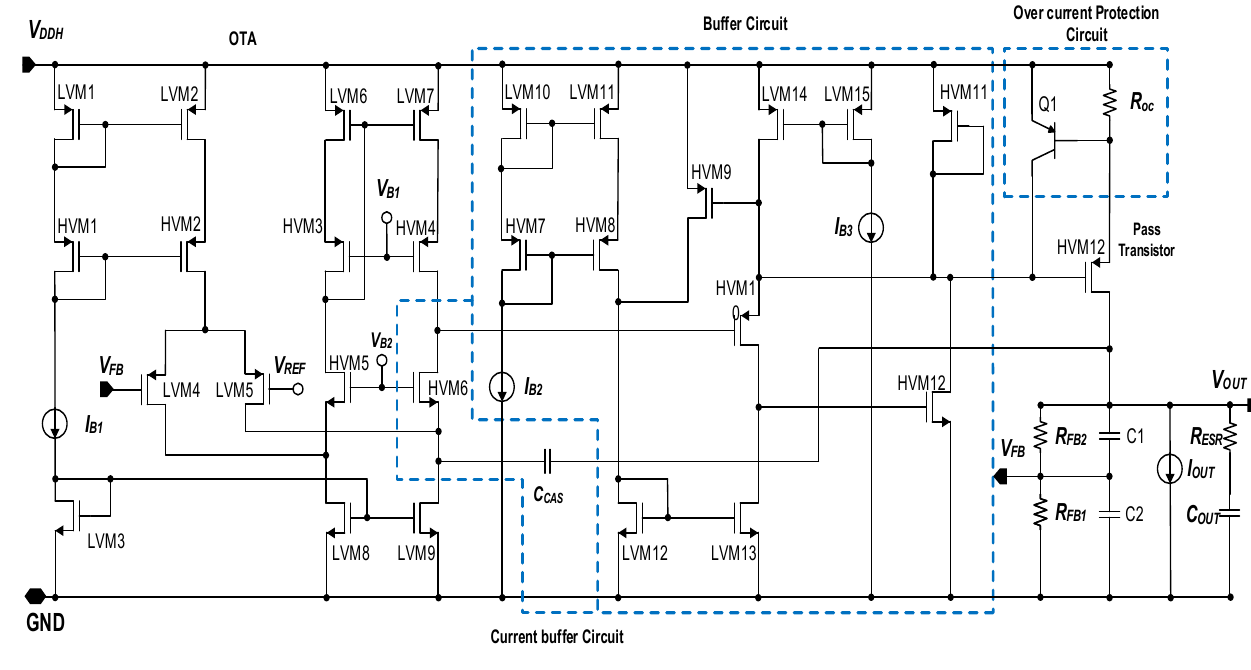
Figure 6. Schematic diagram of the implemented high-voltage